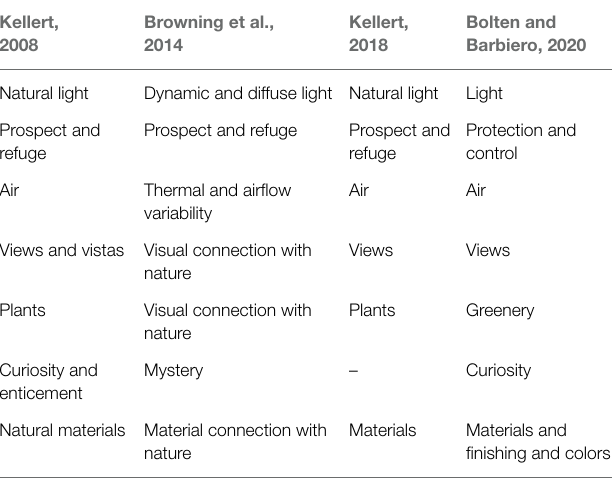
TABLE 2 | Comparison of the most important features of biophilic design according to the most relevant